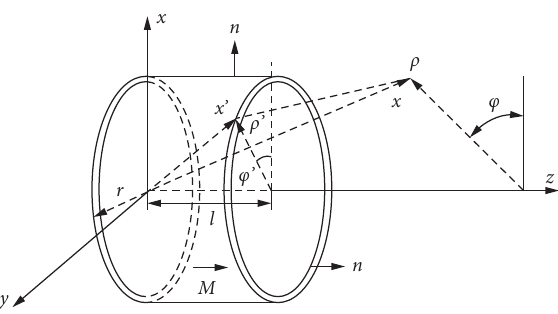
Figure 4: New motor model in + x